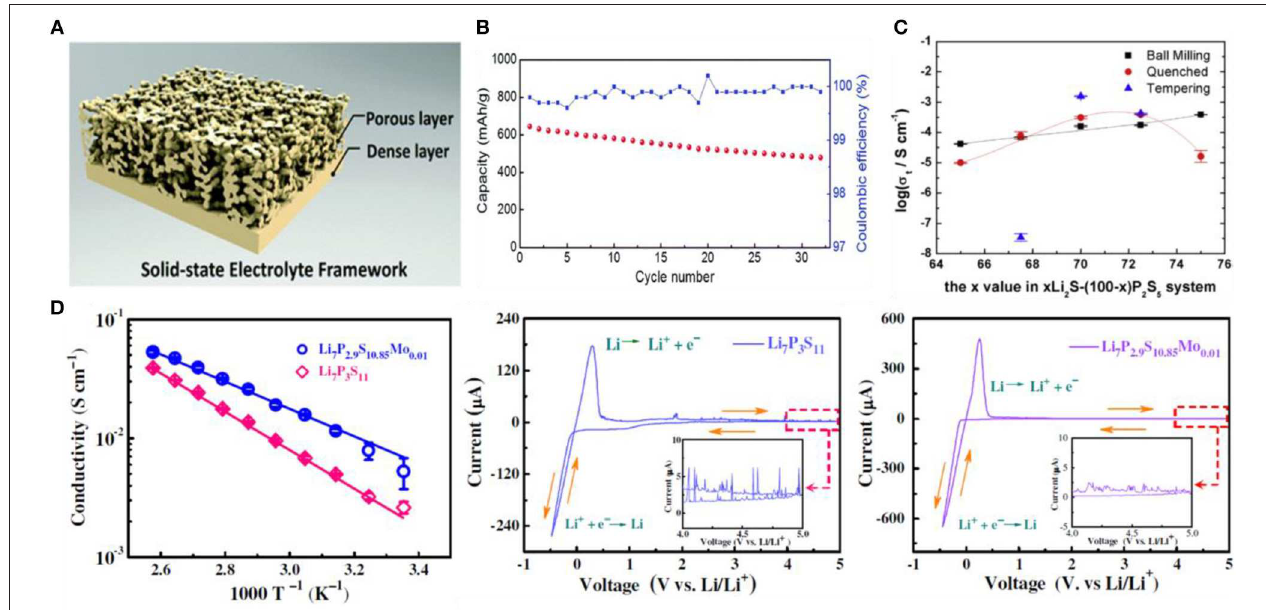
FIGURE 4 | Inorganic solid electrolyte (A) Schematic of the garnet bilayer framework. (B) Cycling performance of the hybrid bilayer Li–S cell with a high sulfur mass loading of approximately 7.5mg cm − 2 at 0.2mA cm − 2 . Reproduced with permission ( Machida et al., 2004). Copyright 2016, Advanced Energy Materials. (C) Conductivity map for xLi 2 S · (100 –x)P 2 S 5 (x = 65, 67.5, 70, 72.5, 75) ball-milling glass, quenched glass and heat-treatment glass ceramic at room temperature. Reproduced with permission ( Xu et al., 2017). Copyright 2017, Solid State Ionics. (D) Arrhenius conductivity plots of Li 7 P 3 S 11 and Li 7 P 2.9 S 10.85 Mo 0.01 at temperatures from 298 to 388K and the corresponding CV curves of Li metal cells show the electrochemical window. Reproduced with permission ( Kobayashi et al., 2008). Copyright 2017, Journal of Materials Chemistry A.